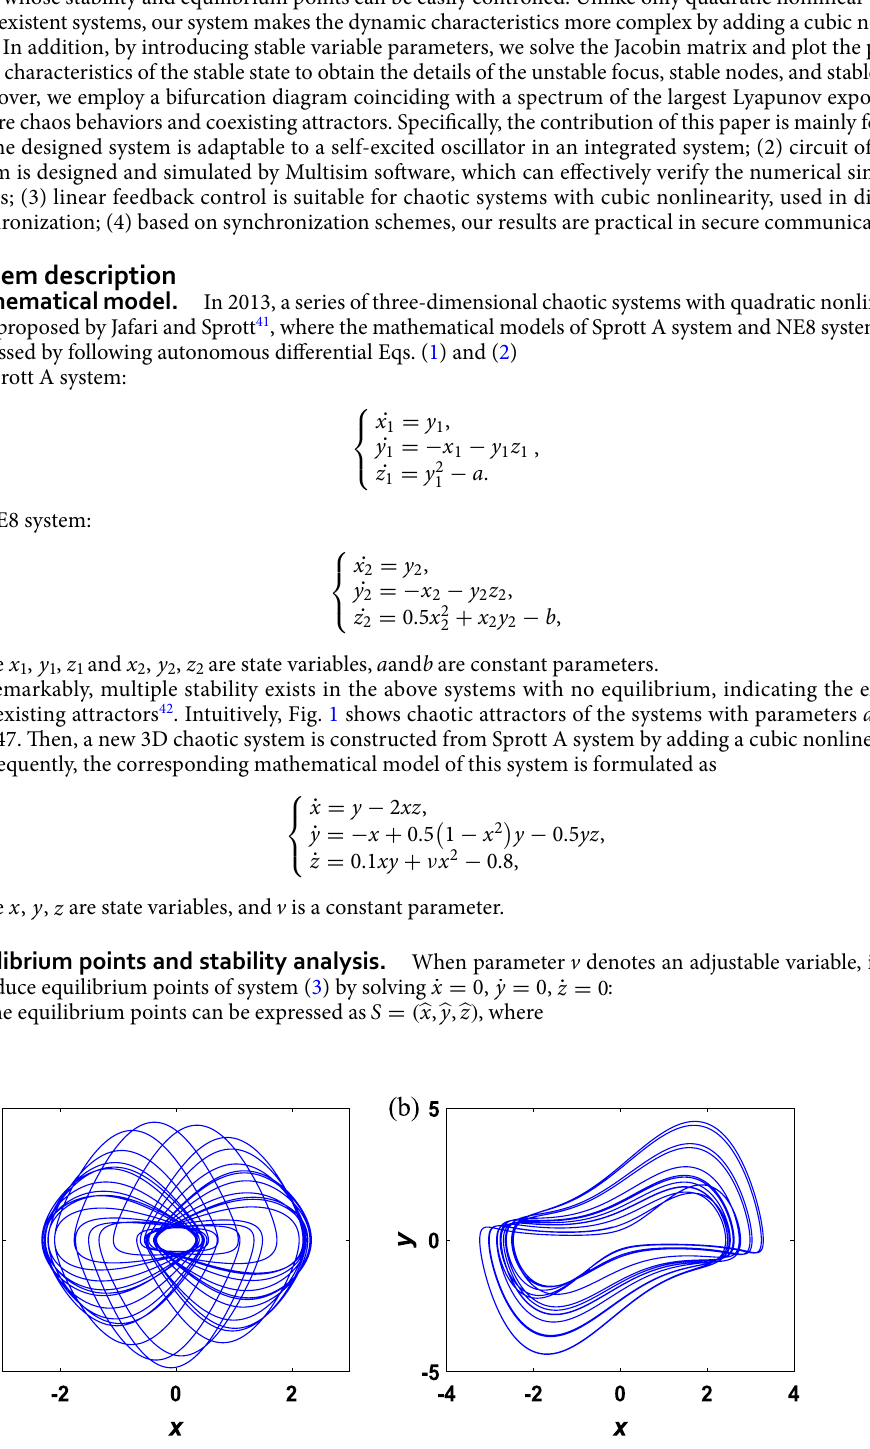
Figure 1. Chaotic attractors of systems (1) and (2) with ( a ) parameter a = 1 and initial condition (− 0.1, − 1, 0.3). ( b ) Parameter b = 1.47 and initial condition (0, 0.1,